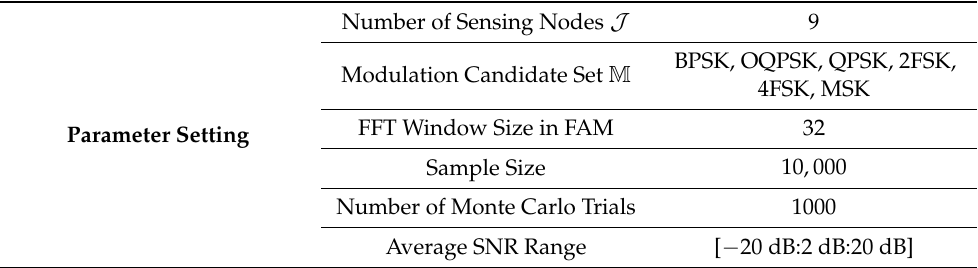
Table 5. The parameter setting and the P cc’s of our proposed CAMC Approach and the existing OHDF CAMC method in